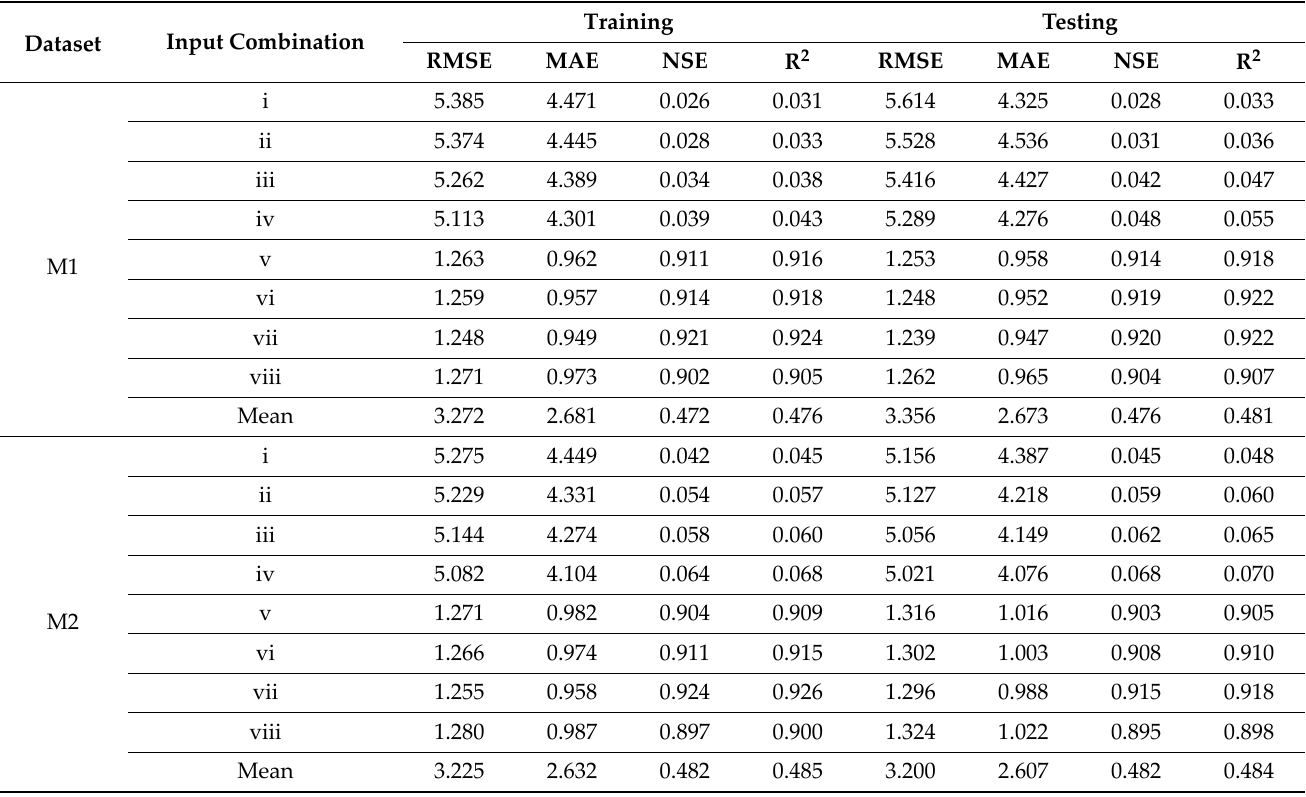
Table 7. The results of the model RVFL for daily time